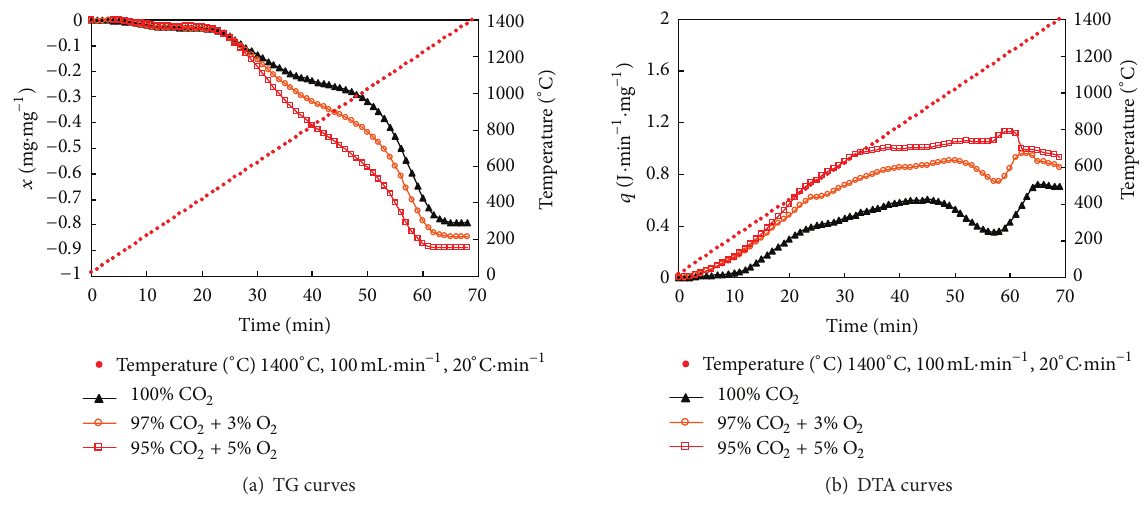
Figure 11: TG-DTA curves of different O 2 concentrations with a temperature of 1400 ∘ C.